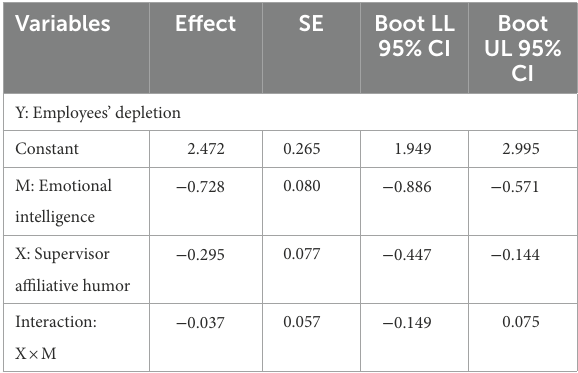
TABLE 5 Emotional intelligence as a moderator in the relationship between supervisor affiliative humor and employees’ depletion.